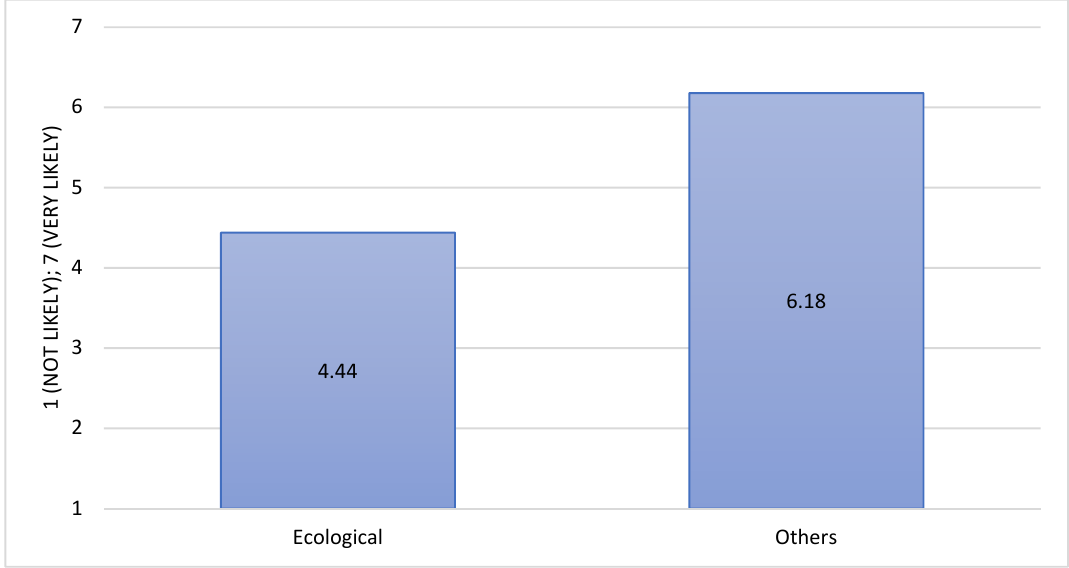
Figure 9. Probability of adopting agroecological practices in the future depending on the type of agriculture practiced by the farmers.